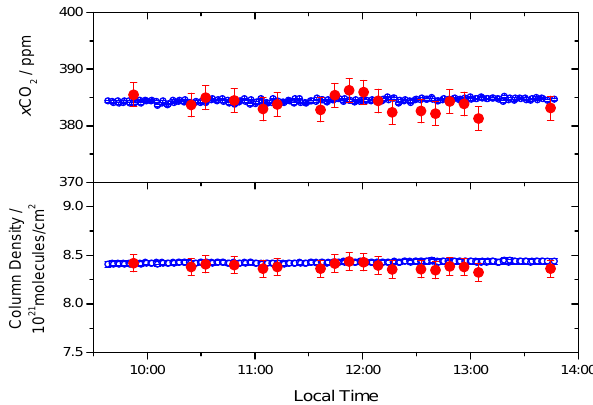
Fig. 3. Time series of column density and x CO 2 on 3 July 2010 at UoW in Australia. OSA: solid circles (scale factor for x CO 2 : SF=1.008); FTS: open circles with estimated errors